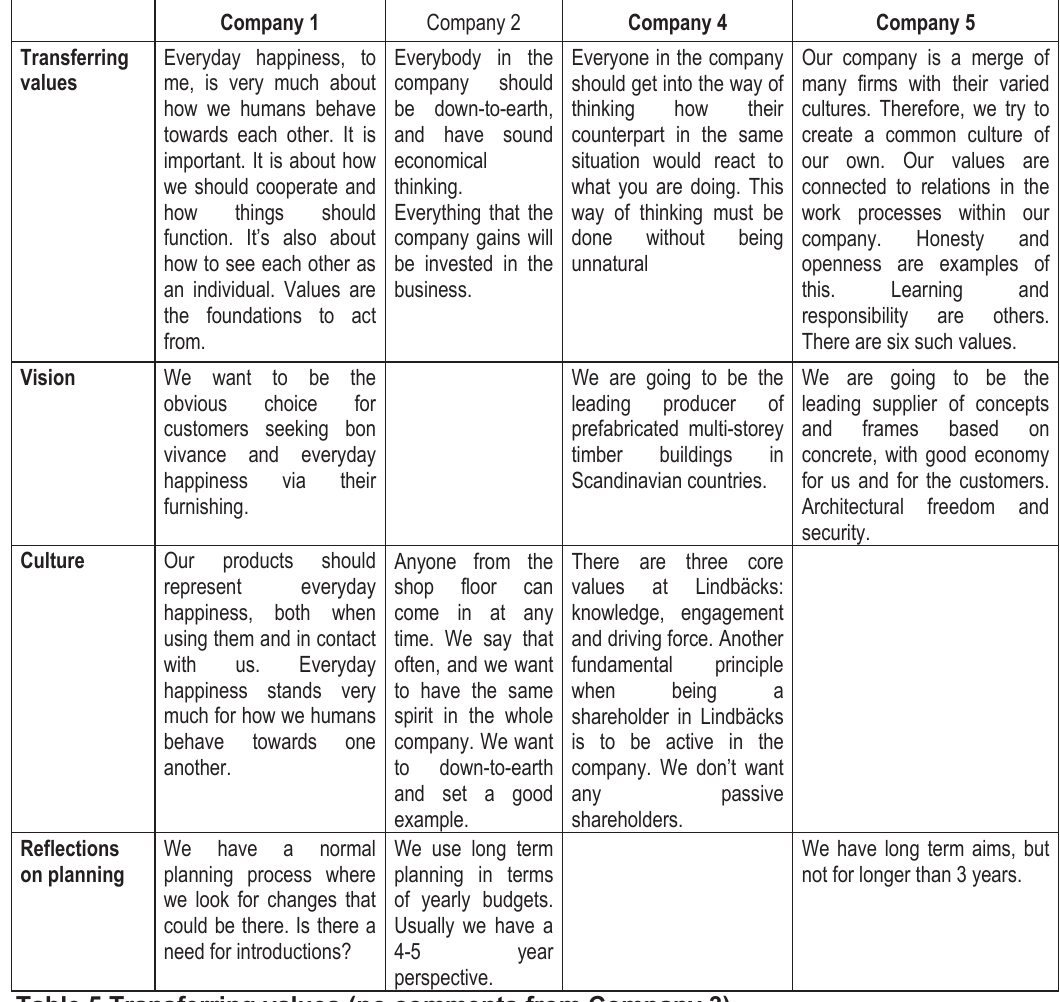
Table 5 Transferring values (no comments from Company